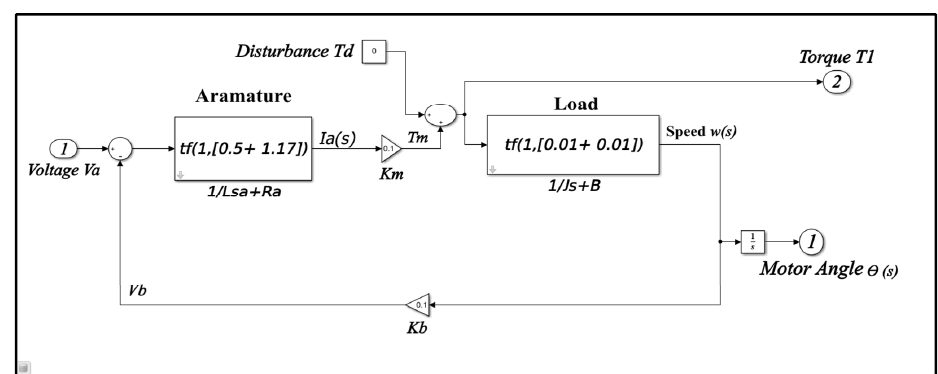
Fig. 6. Kinematics modelling of DC Servo motor using Simulink.